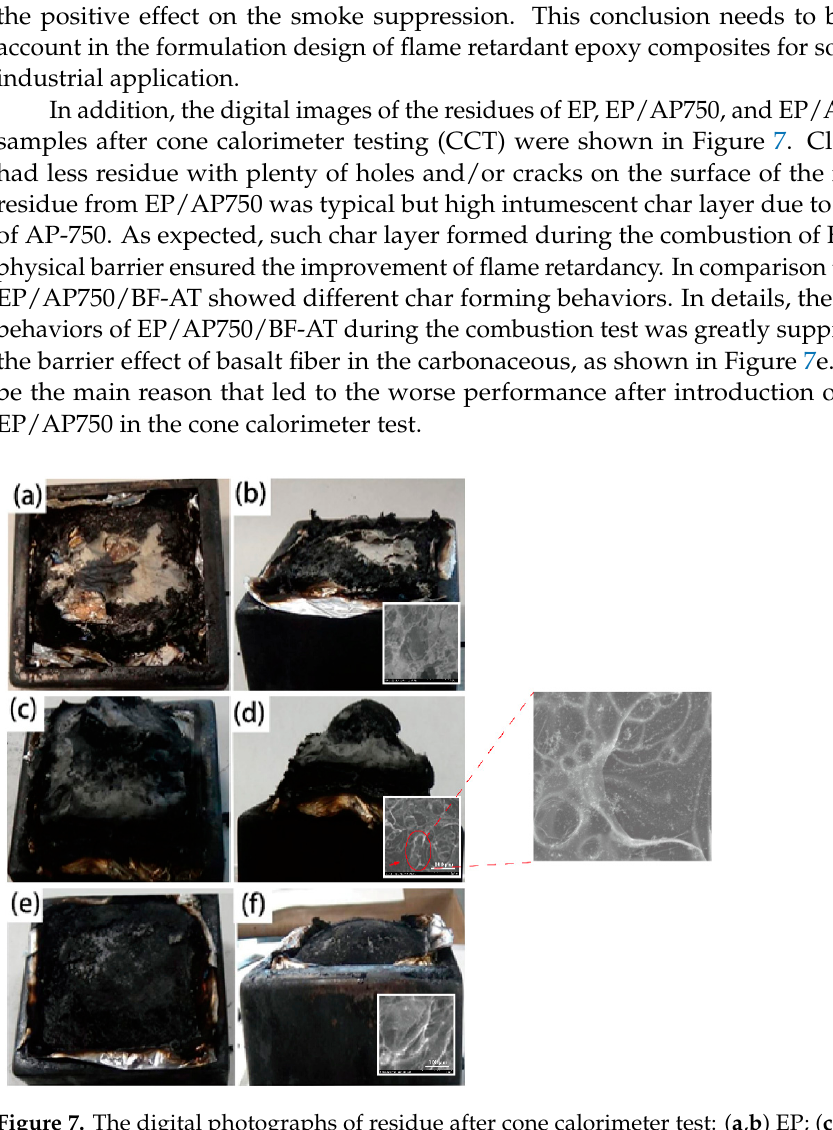
Figure 6. Cone calorimeter results of EP, EP/AP750 and EP/AP750/BF-AT in ( a ) heat release rate (HRR), ( b ) total heat release (THR), and ( c ) smoke produce rate (SPR). Table 4. Cone calorimeter test (CCT) data of EP and EP composites.